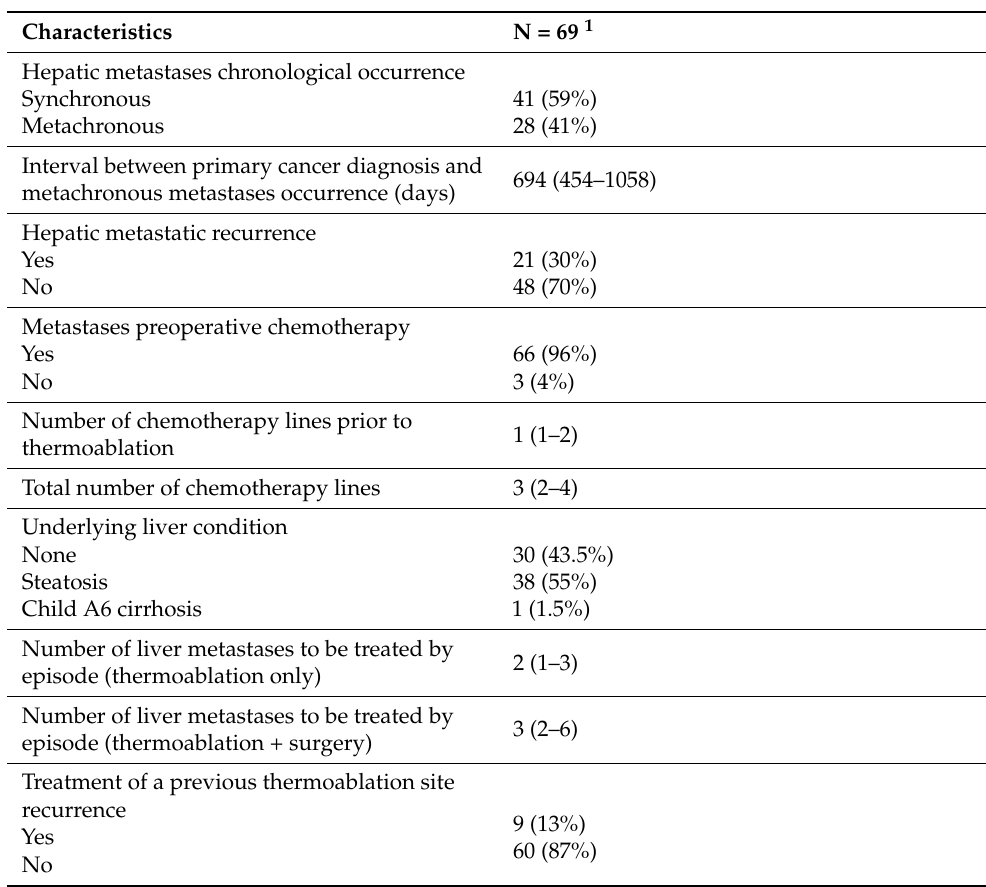
Table 2. Liver disease